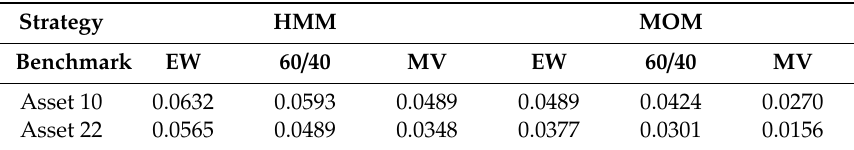
Table 7. Jensen’s Alpha Result.